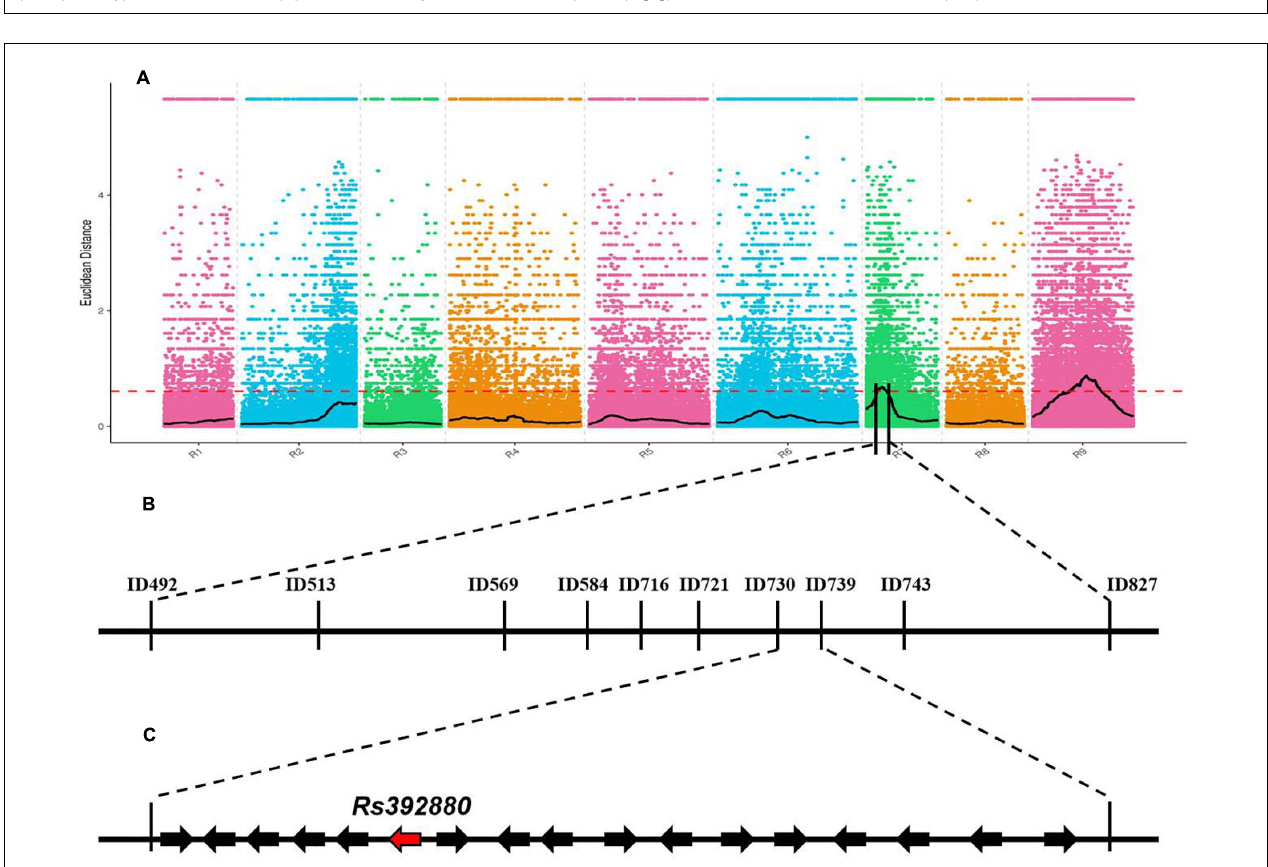
FIGURE 2 | BSA-seq based mapping of gene RsPP BSA-seq analysis using Euclidean Distance (ED) algorithm (A) . The candidate gene was confined to a region of 93.23 kb on chromosome 7 (B,C) . The red dashed line represents the significant threshold.